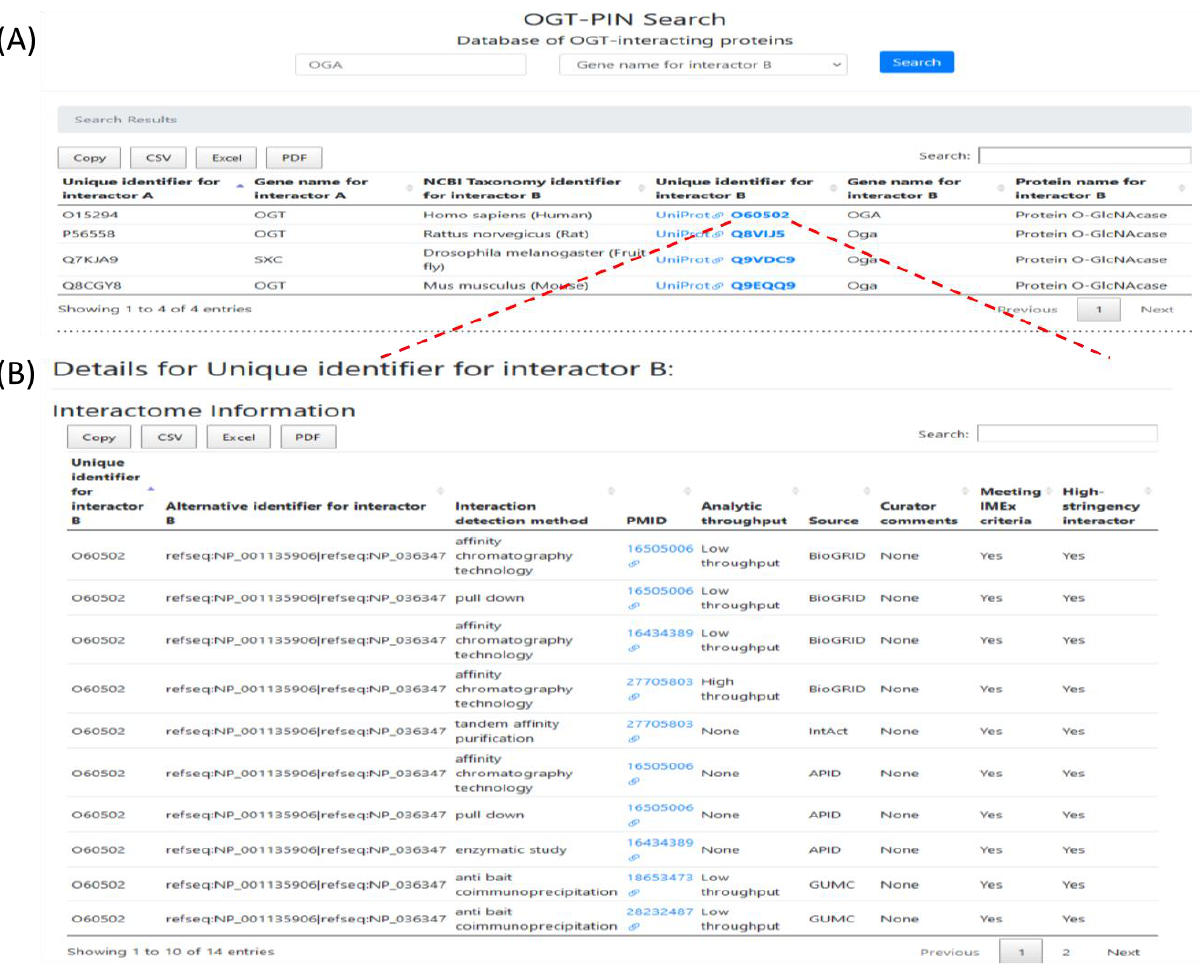
Figure 8. A snapshot for searching the webserver OGT Protein Interaction Network (OGT-PIN), with ‘Protein O-GlcNAcase (OGA)’ as an example. The top panel ( A ) are the tabular results for all the four matched entries identified from different species, and the bottom panel ( B ) shows detailed information of 14 entries matched with human OGA, with links to the original studies in PubMed. Among the 14 entries meeting IMEx criteria, one entry was excluded from the high- stringency list.